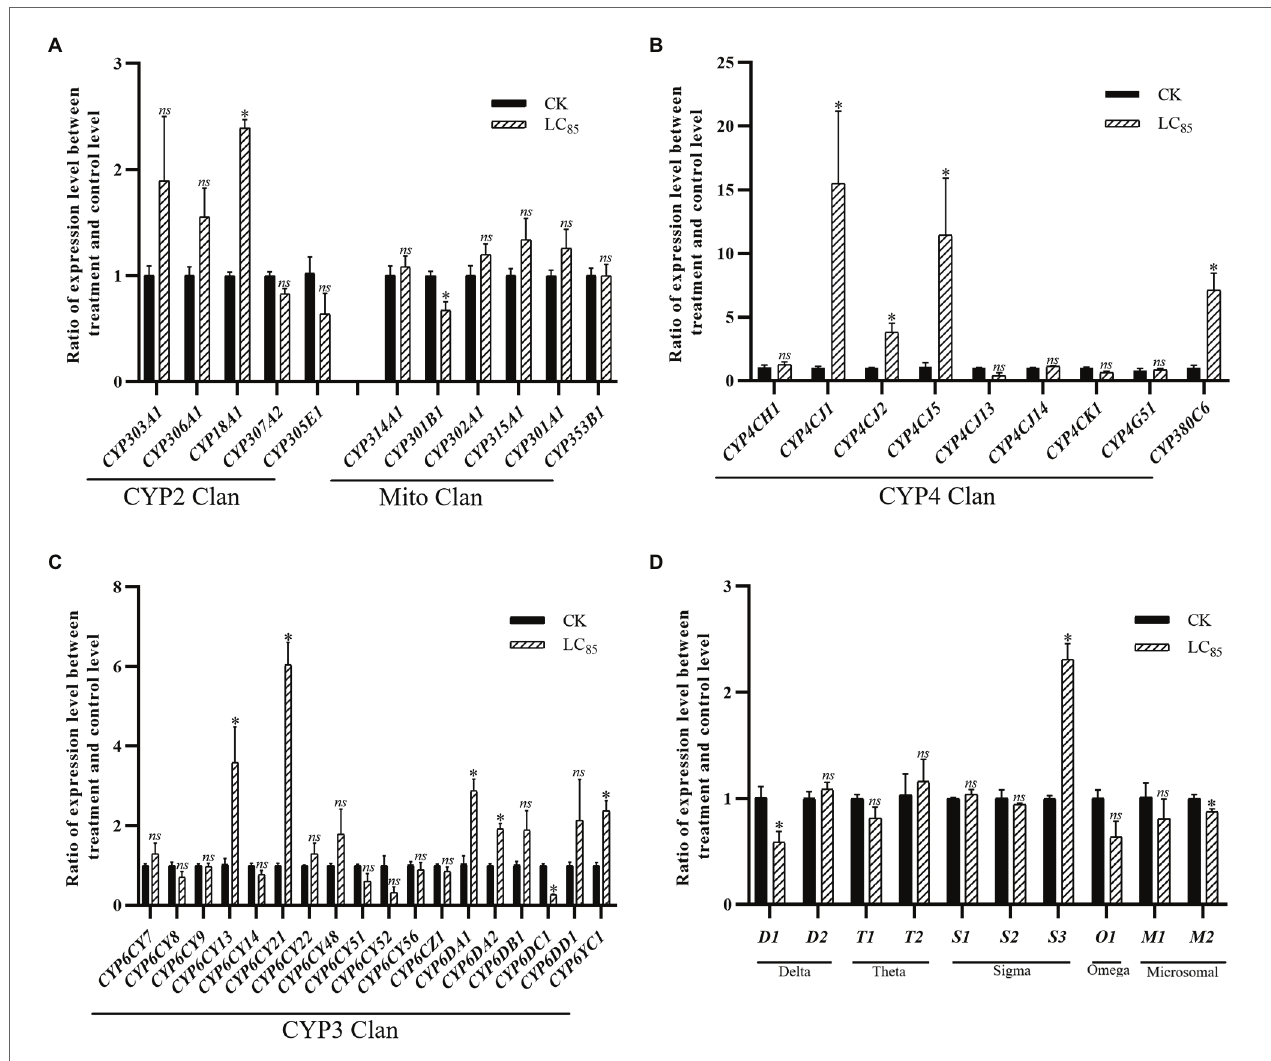
FIGURE 5 | Fold changes in the expression of 38 P450 genes and 10 GST genes in the A. craccivora susceptible strain after the LC 85 dose of imidacloprid treatment. The significant differences were marked by asterisks. *Significantly at 0.05 level. The ns represents no significant difference. (A) Fold changes in the expression of P450 genes from CYP2 and Mito Clan. (B) Fold changes in the expression of P450 genes from CYP4 Clan. (C) Fold changes in the expression of P450 genes from CYP3 Clan. (D) Fold changes in the expression of GST